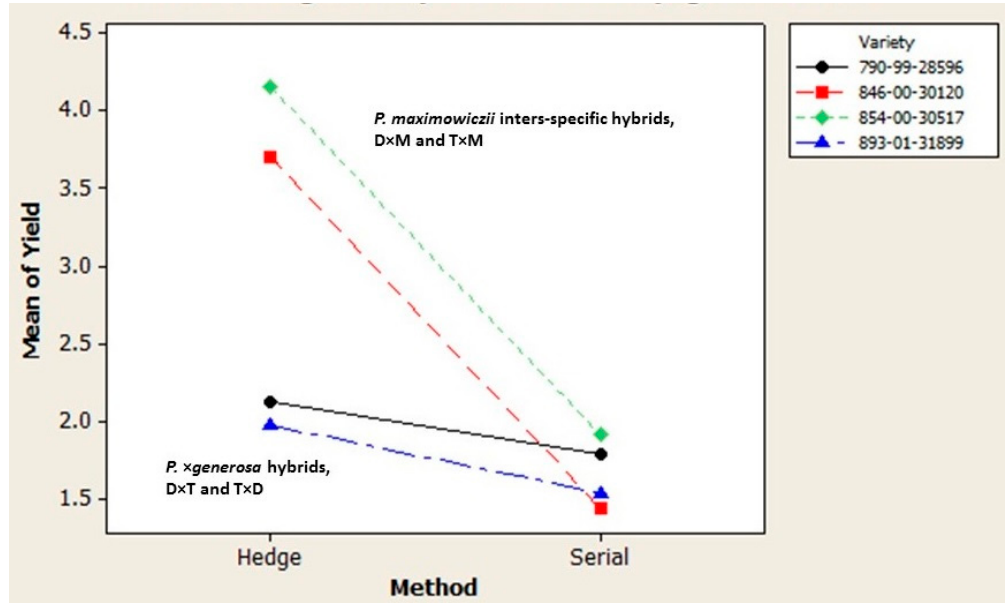
Figure 2. Varietal variation in the response of macro-cutting yield to propagation method.